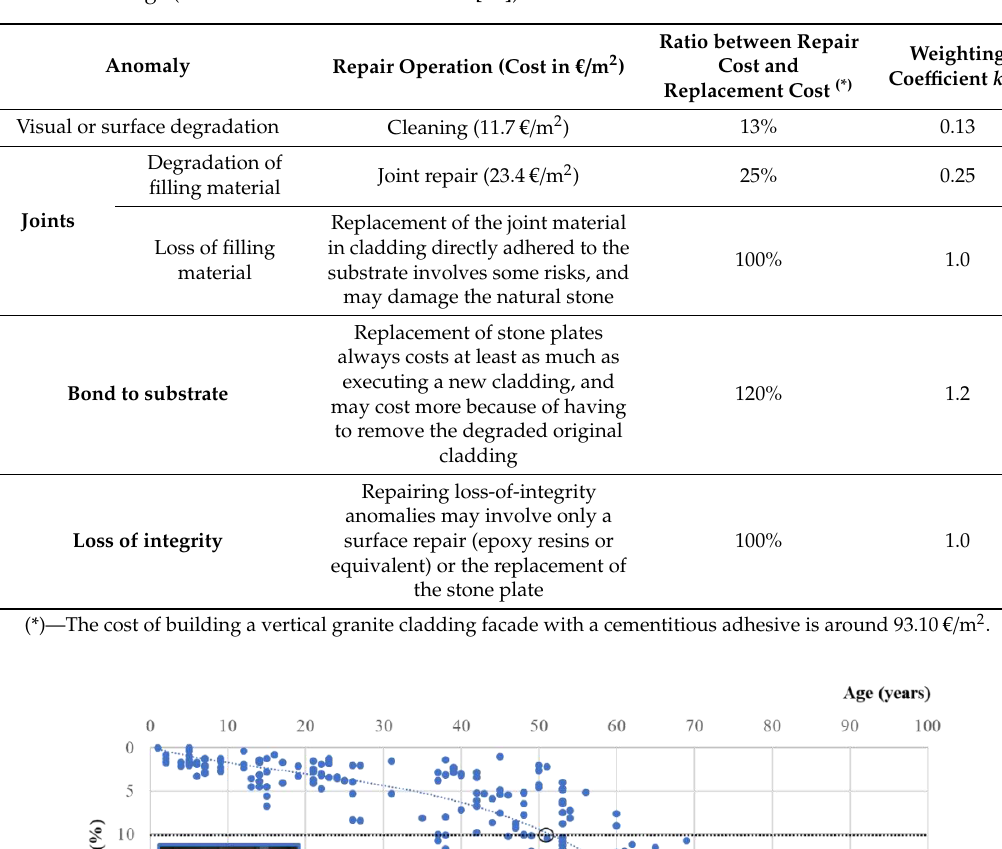
Table 2. Weighting coe ffi cients corresponding to the relative weight of the anomaly detected in natural stone claddings (data sourced from Silva et al. [12]).